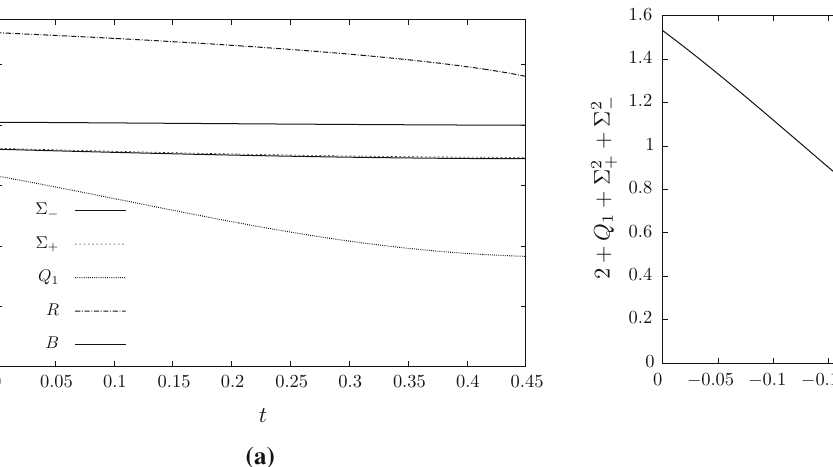
decreases, which is consistent with Eq. (61) when Q 1 < − 3. In b ) it is explicitly shown that the numerical solution approaches Eq. (19), as it should for all points of the past attractor. Even if not reported in the plot, the constraint has been checked to be satisfied